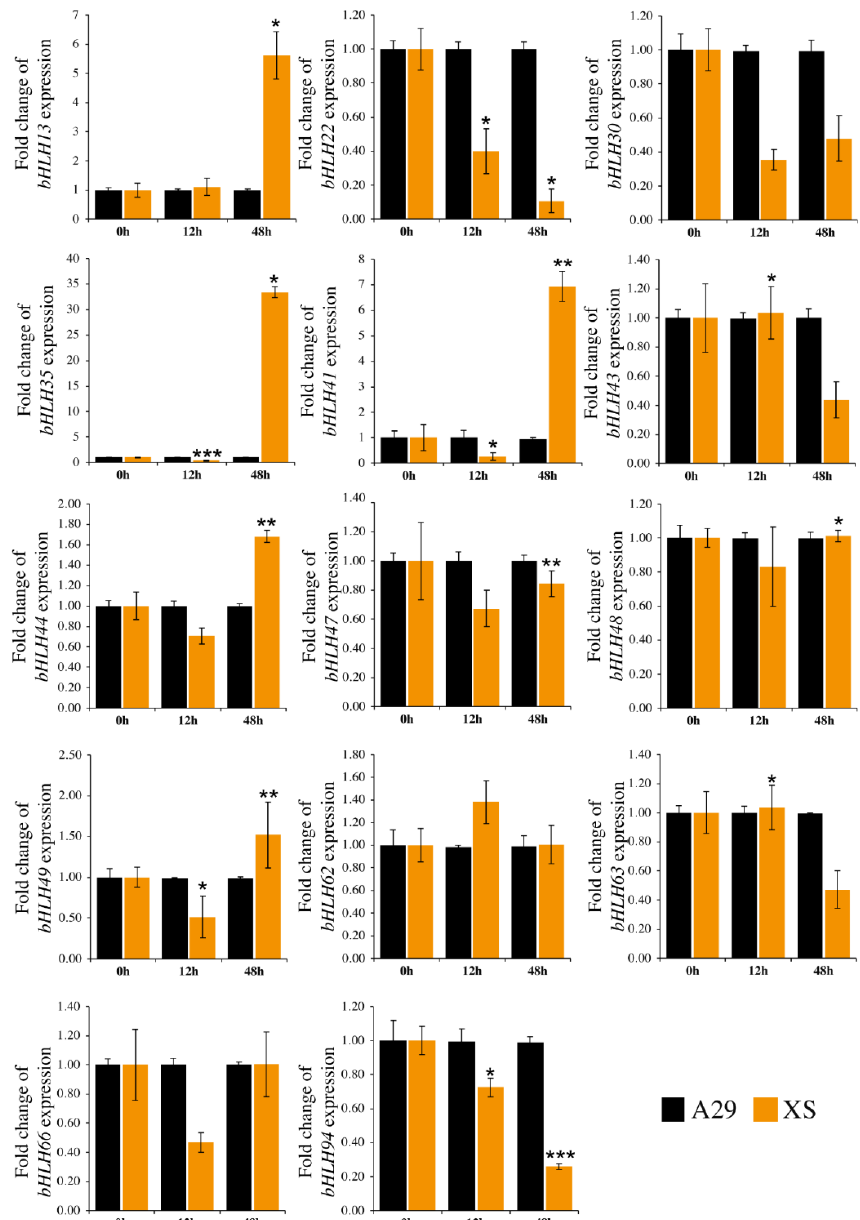
Figure 8. Quantification of RcbHLH genes in A29 and XS varieties under control and stress conditions. Samplings were taken at 12 h and 48 h after treatment. *, * and *** are significant at p < 0.05, 0.01, and 0.001, respectively.